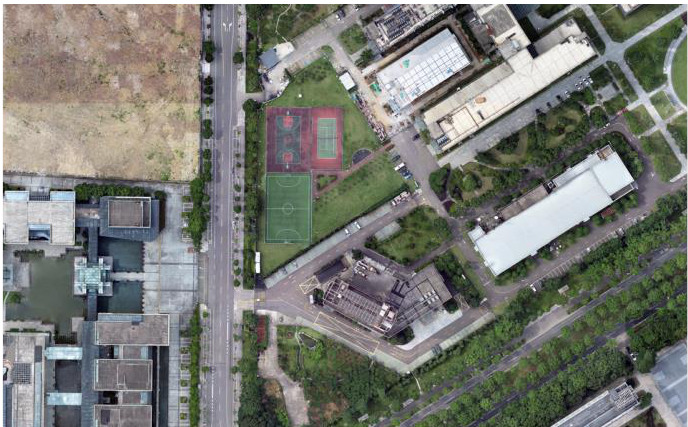
Figure 3. Orthographic projection map with geographic information.